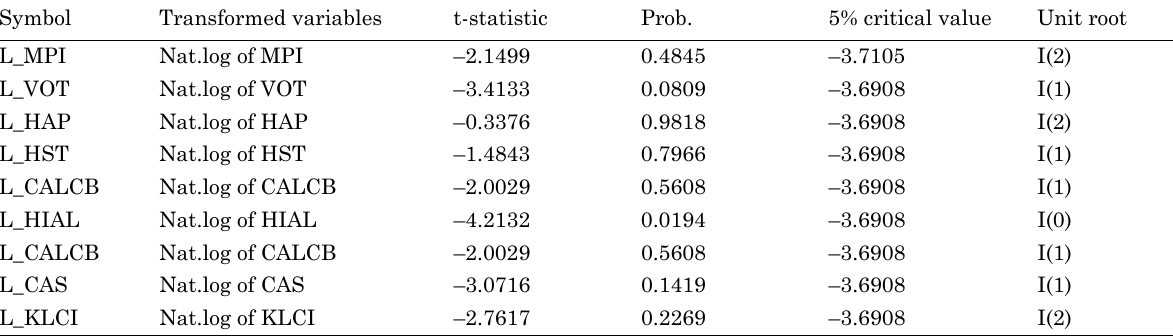
Table 4. Augmented Dicker-Fuller unit-root test (intercept with trend) Symbol Transformed variables